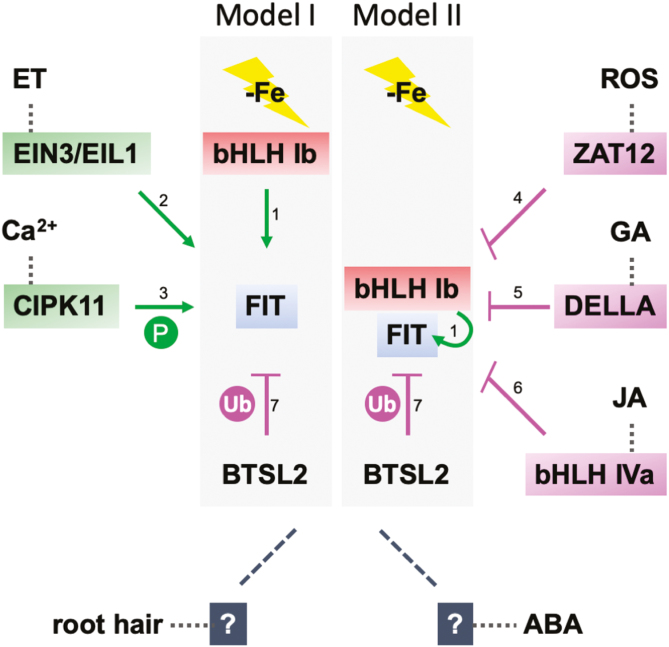
FIT as a regulatory hub for integrating signals from multi-parallel signaling pathways. The proteins, indicated in the model, interact directly via protein–protein interactions with FIT in plant cells (indicated by solid lines) to adjust Fe acquisition in response to the respective signals. Root hair development and ABA are prospective signals for FIT regulation, as highlighted in this review; however, interacting proteins remain to be identified (indicated by dashed lines and question marks). The light gray boxes indicate two models for interaction, either protein interactions only with FIT (Model I, left side) or protein interactions with the FIT–bHLH subgroup Ib protein complex (Model II, right side). Abbreviations used are –Fe, Fe deficiency; ET, ethylene; ROS, reactive oxygen species; GA, gibberellic acid; JA, jasmonic acid; P, phosphorylation; Ub, ubiquitination; ABA, abscisic acid. Green color, positive effect; pink color, negative effect; dark gray color, positive or negative effect not yet determined; red color, cluster 1-encoded; blue color, cluster 2-encoded. References are 1(Yuan et al., 2008; Wang et al., 2013), 2(Lingam et al., 2011), 3(Gratz et al., 2019), 4(Le et al., 2016), 5(Wild et al., 2016), 6(Cui et al., 2018), and 7(Rodriguez-Celma et al., 2019).